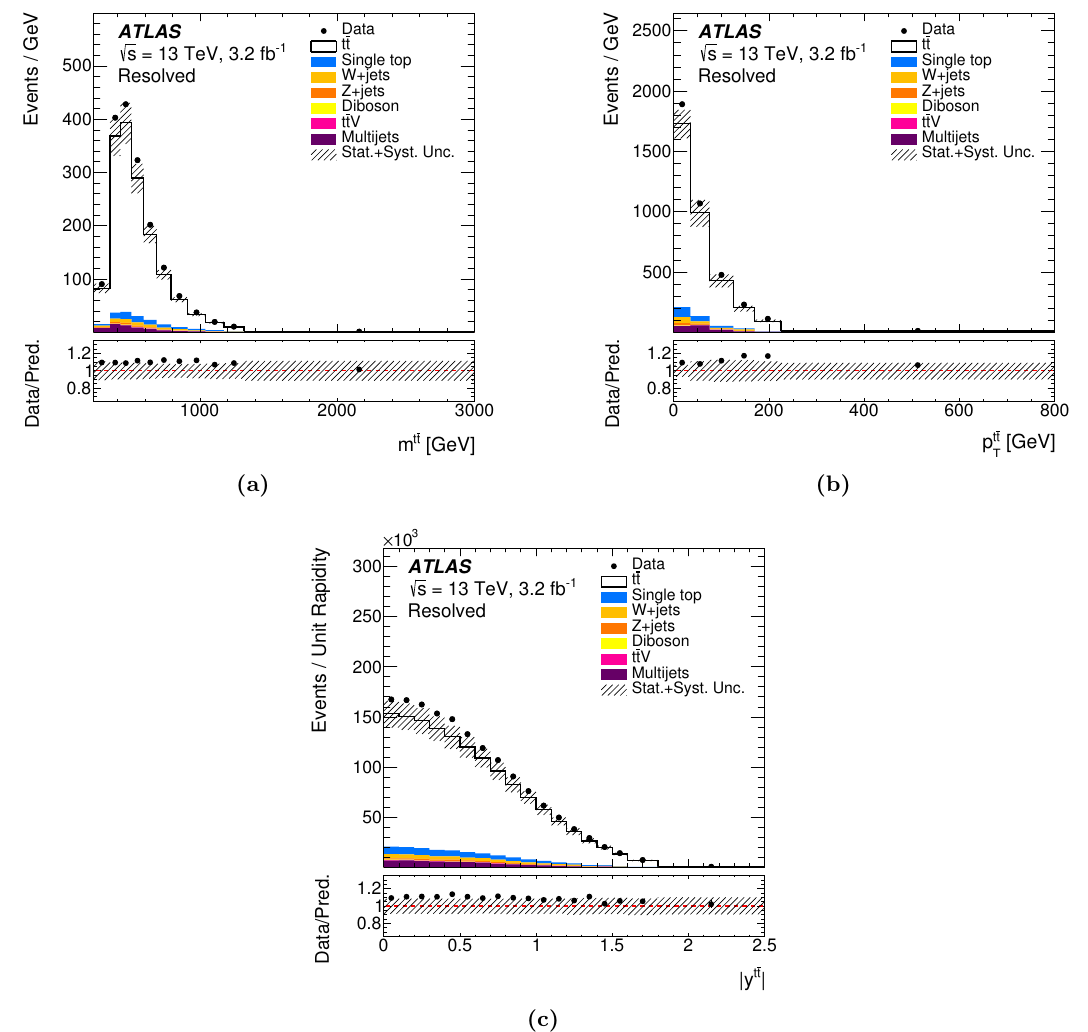
Figure 7. Distributions of observables in the resolved topology in the combined ‘ +jets channel at detector level: (a) t (cid:22) t invariant mass m t (cid:22) t , (b) transverse momentum p t (cid:22) t (cid:12) (cid:22) t (cid:12) the rapidity (cid:12) y t (cid:12) . Data distributions are compared to predictions, using Powheg + Pythia6 as the t (cid:22) t signal model. The hatched area indicates the combined statistical and systematic uncertainties (described in section 9) in the total prediction, excluding systematic uncertainties related to the modelling of the t (cid:22) t